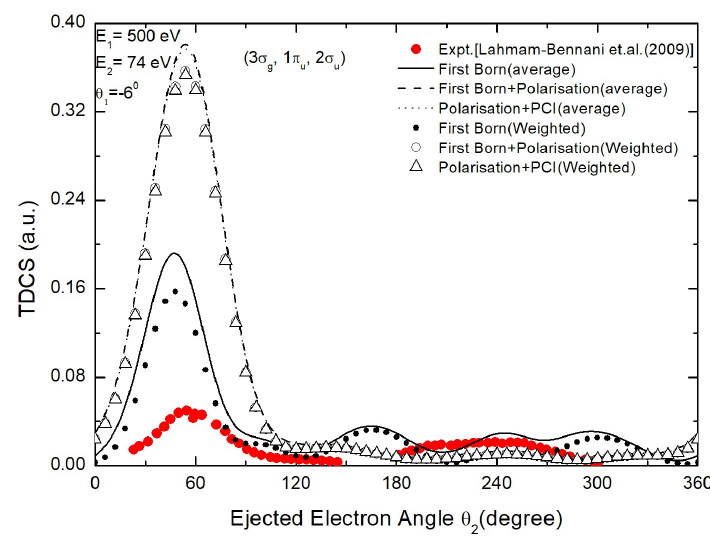
Figure 2. Same as Figure 1. The ejected electron energy is 74 eV.